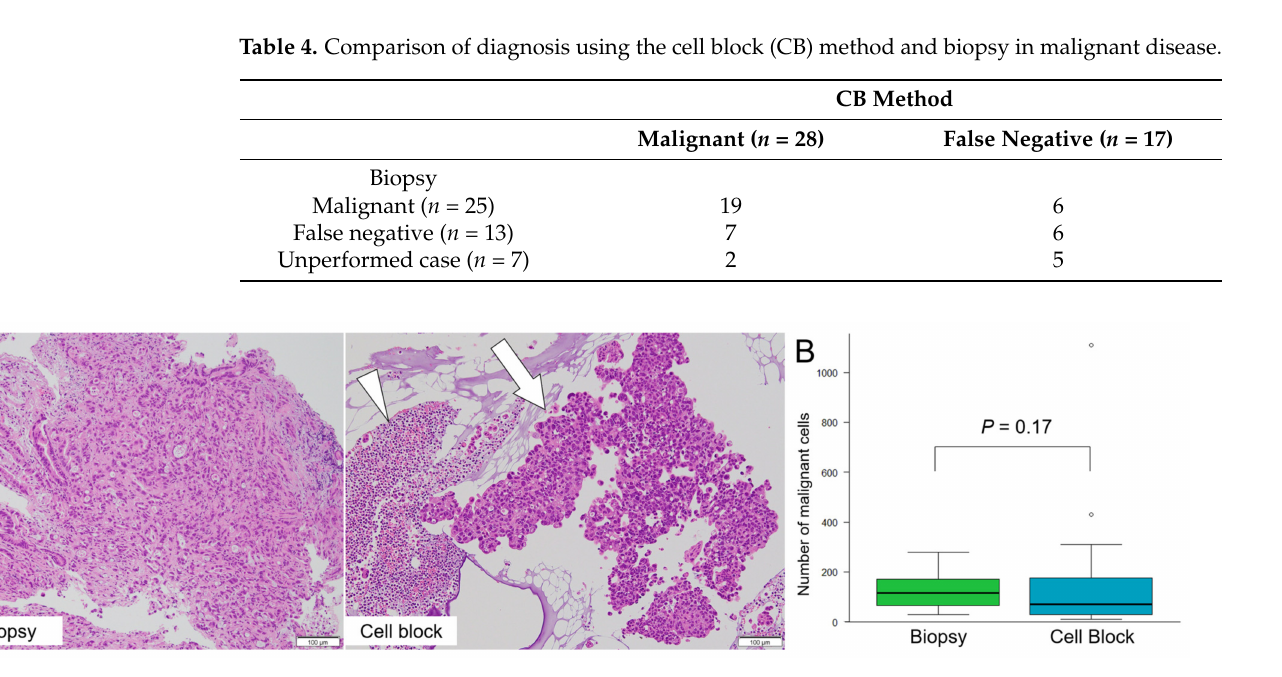
Figure 4. The comparison of malignant cell count on the cell block (CB) and biopsy specimens. ( A ) Degenerated cells (arrowhead) and cancer cells cluster (arrow) are easily identifiable on a CB specimen using overnight-stored bile after centrifugation. ( B ) The mean number of malignant cells on a glass slide with the CB and biopsy specimens was 70 (range: 10–1110) and 110 (range: 30–280), respectively. There is no significant difference between the CB method and biopsy specimens ( p =